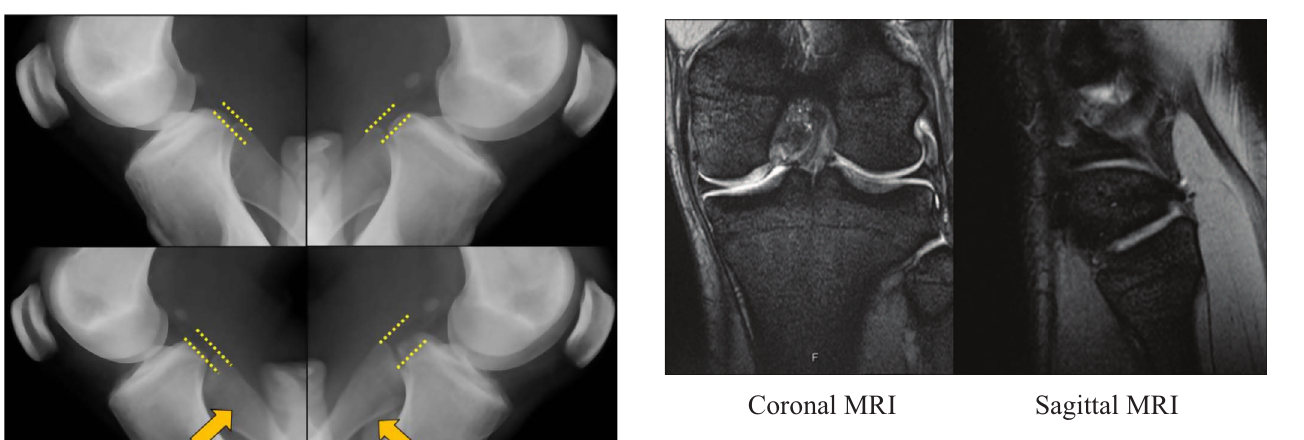
Figure 3. T2-weighted MRI fi ndings. No obvious lateral meniscus injury and cartilage injury was shown on T2-weighted